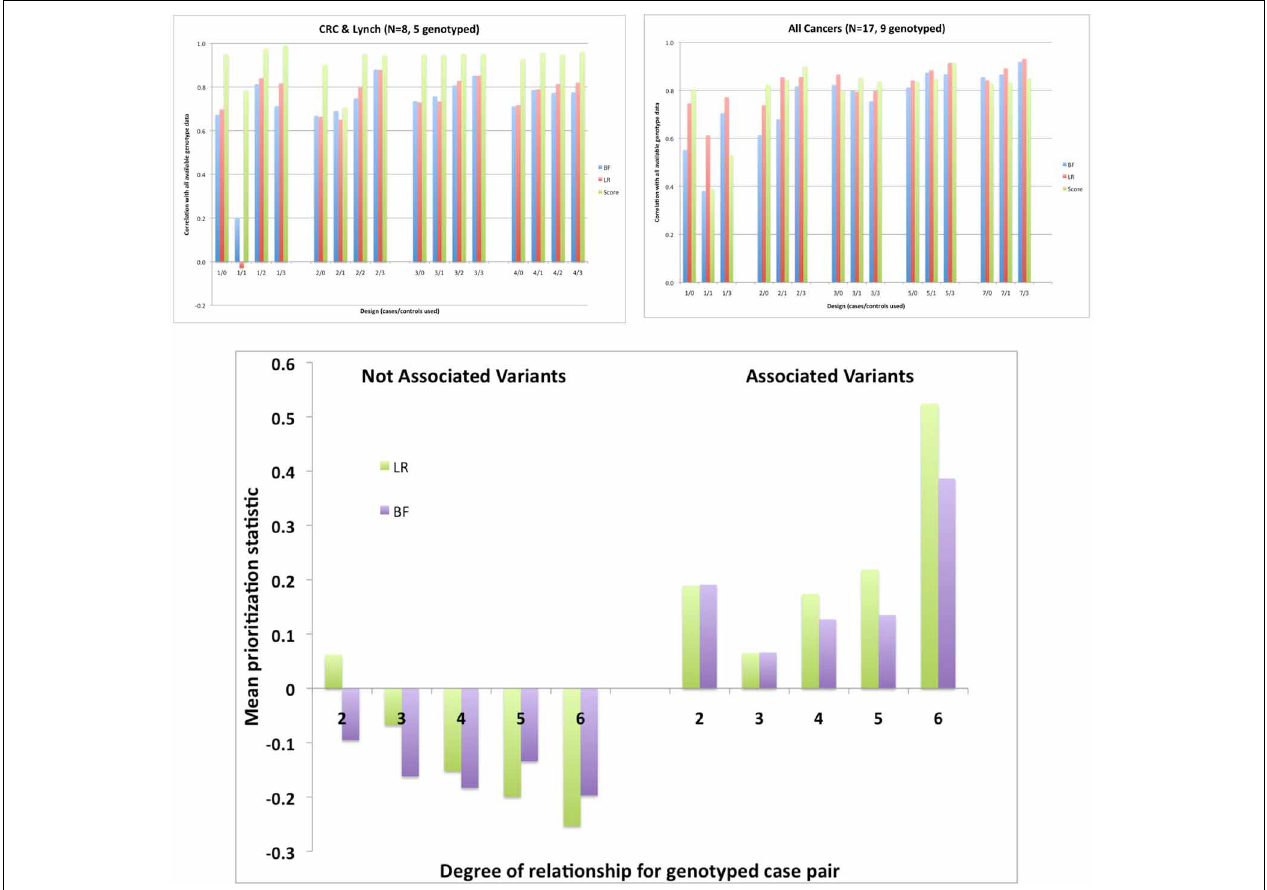
FIGURE 4 | Correlation across 32 GWAS SNPs between the statistics computed from the complete genotype data and those computed using only the genotypes for various subsets of members; top left: 5 genotyped CRC and Lynch syndrome cases; top right: 9 cases of any cancer. Bottom: prioritization